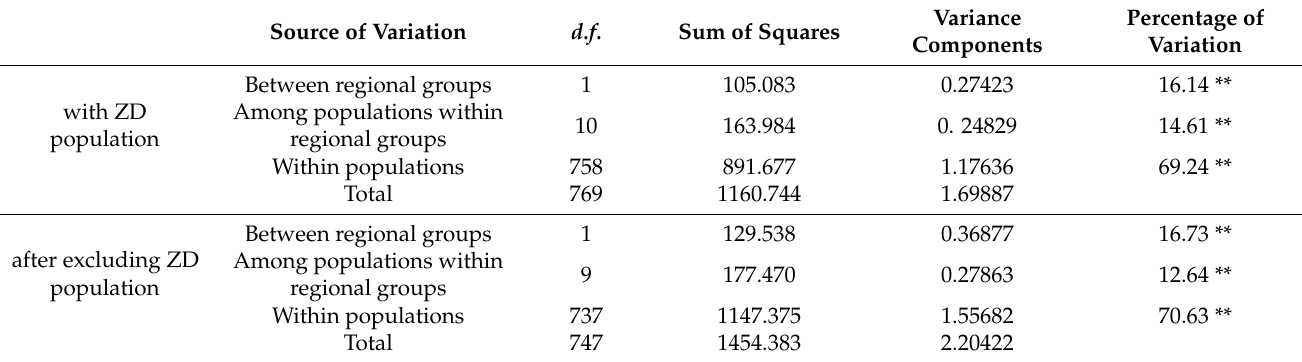
Table 4. Results of hierarchical AMOVA testing for Camellia nitidissima